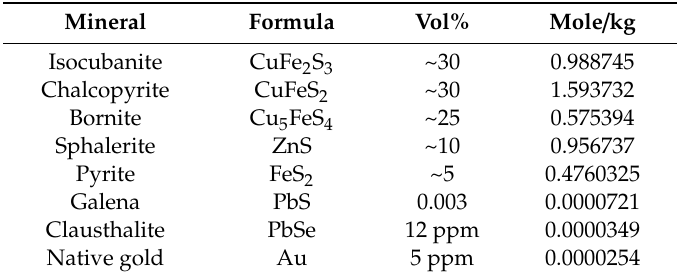
Table 3. Model composition of massive sulfides. Mineral Formula Vol% Mole / kg